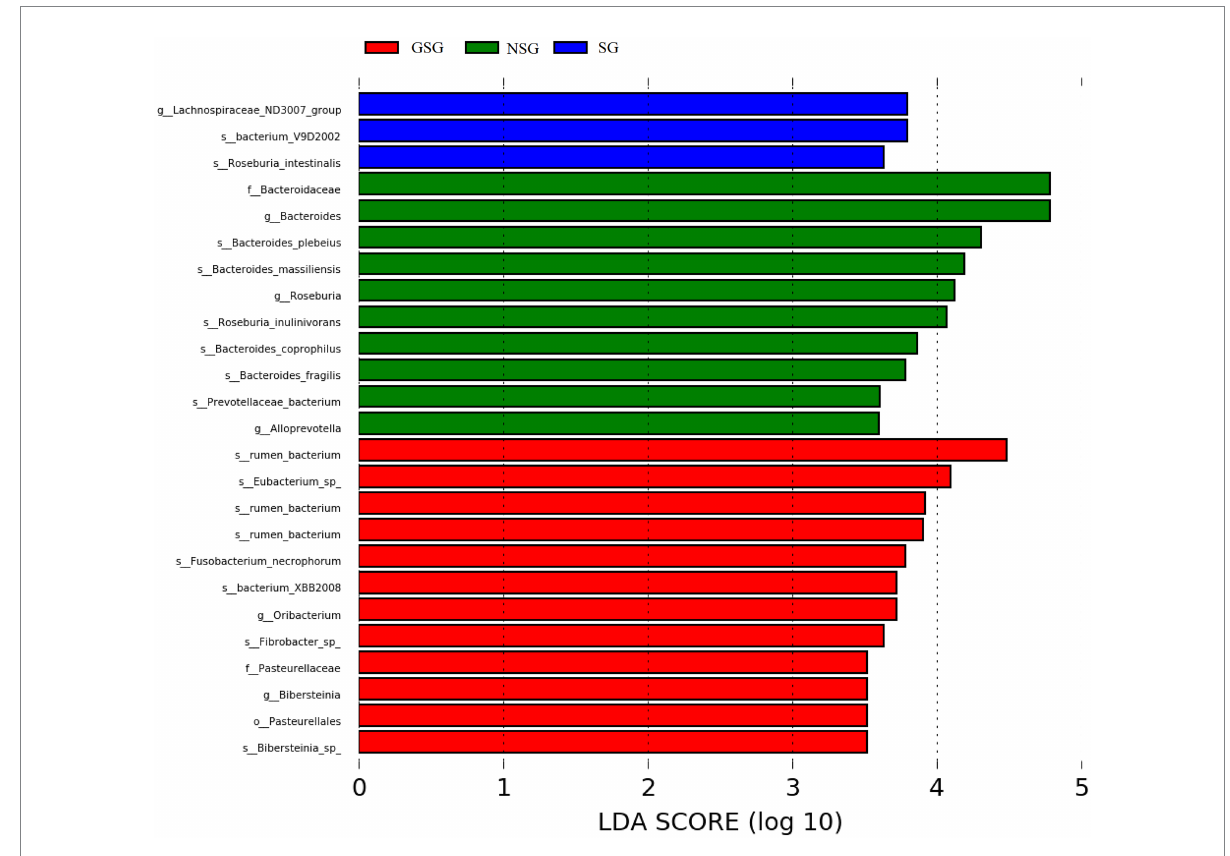
FIGURE 3 Linear discriminant analysis (LDA) of rumen bacteria. (LDA cutoff of +/ −